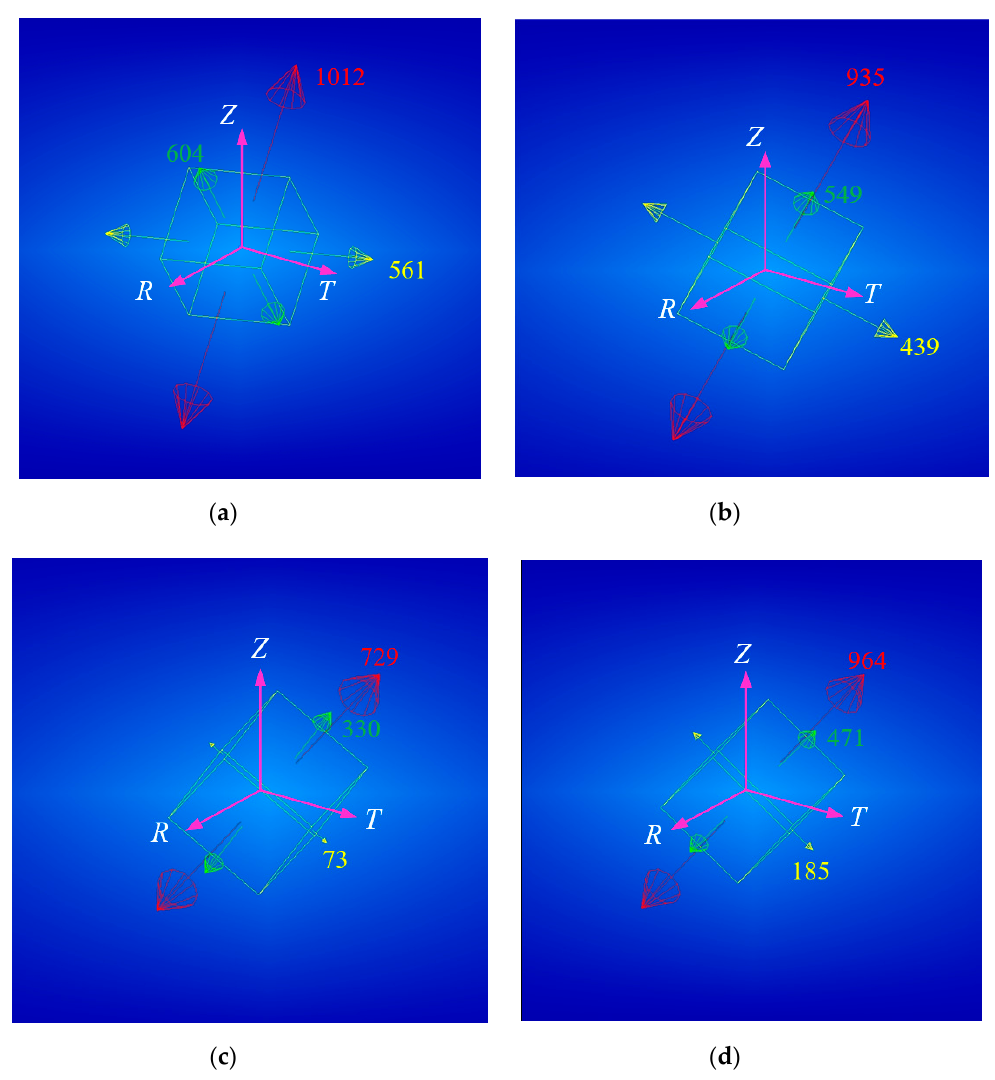
Figure 20. Display of principal stress tensors when σ 1 was the maximum for the case of RP steel ( ∆ K III / ∆ K I = 1.5, R I = 0.05, R III = − 1). ( a ) δ = 30 ◦ , ( b ) δ = 90 ◦ , ( c ) δ = 120 ◦ , and ( d ) δ = 180 ◦ . Red arrow indicates σ 1 max , and green and yellow arrows indicate σ 2 and σ 3 , respectively. Their lengths represent the relative magnitudes and the figures are in MPa. Table 5. Planes of σ 1 max for the case of RP steel ( ∆ K III / ∆ K I = 1.5, R I = 0.05, R III = − 1). δ (deg.)